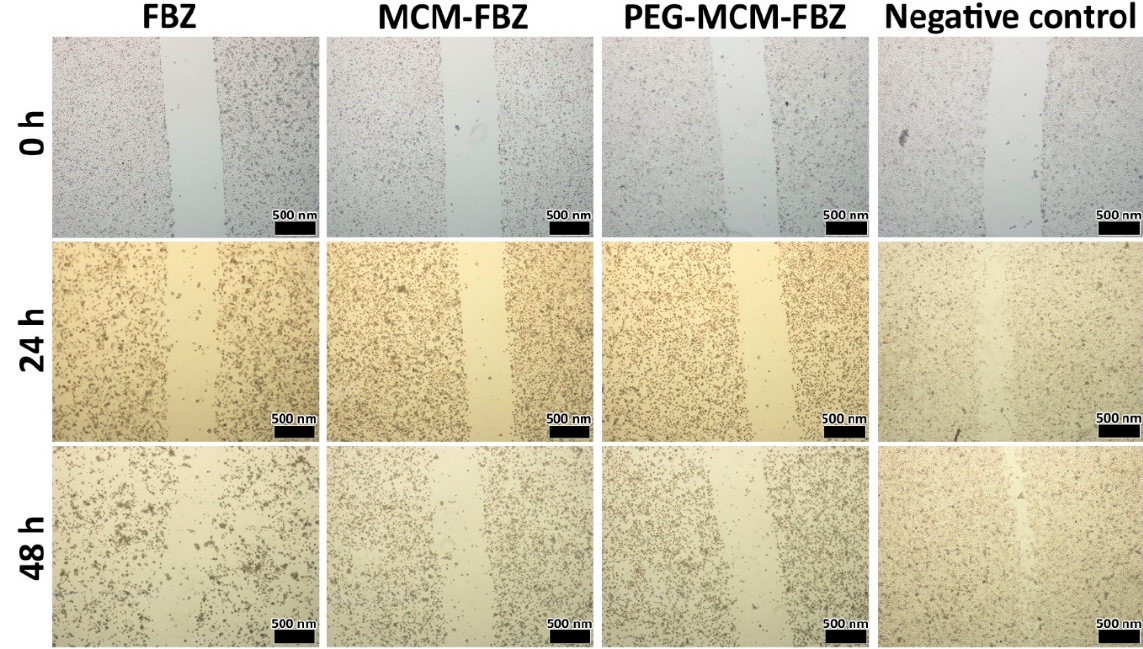
Figure 6. Effects of FBZ, MCM ‐ FBZ NPs, and PEG ‐ MCM ‐ FBZ NPs on prostate cancer PC ‐ 3 cells’ migration and invasion.